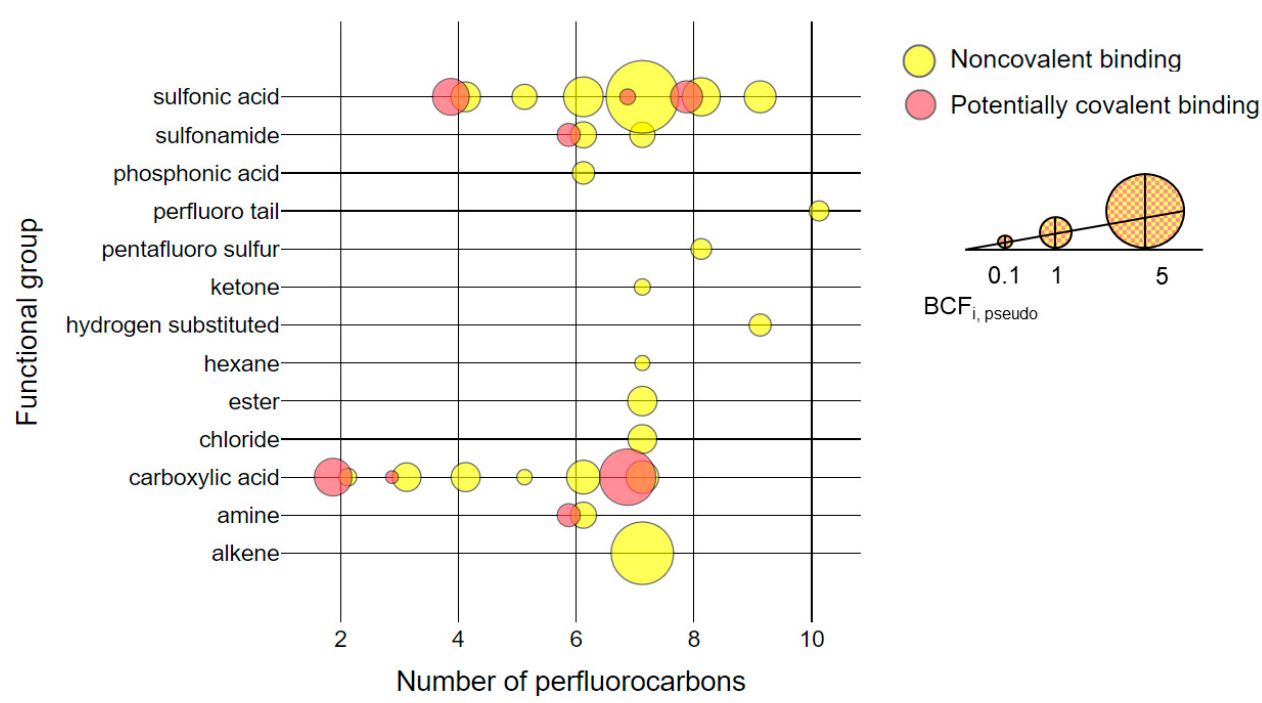
Figure 5. Pseudo-bioconcentration factors (BCF i,pseudo ) of PFAS in aqueous film-forming foams (AFFF) that were bound noncovalently (yellow) or potentially covalently (red) to HSA. Bubble size represents the natural logarithm of the BCF pseudo (legend BCF pseudo = 1). For 12 qualified PFAS with multiple functional groups, a separate bubble of the same size is displayed for each functional group (e.g., noncovalently bound Cl-PFOS contained chloride and sulfonic acid groups and is represented as two bubbles with seven perfluorocarbons).